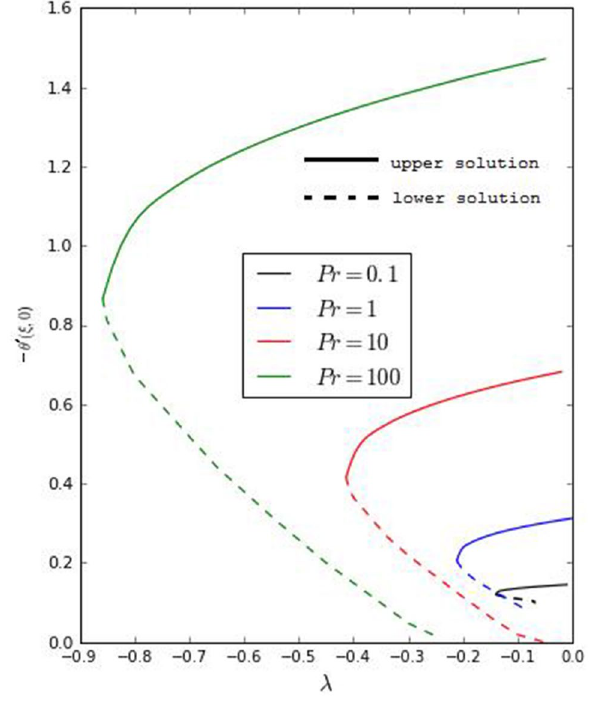
Fig. 7 Profiles for 𝜃 � ( 𝜉 ,0 ) for Pr = 0.1,1,10 and 100 for buoyancy opposing flow ( 𝜆 < 0 ) for fixed 𝜙 =